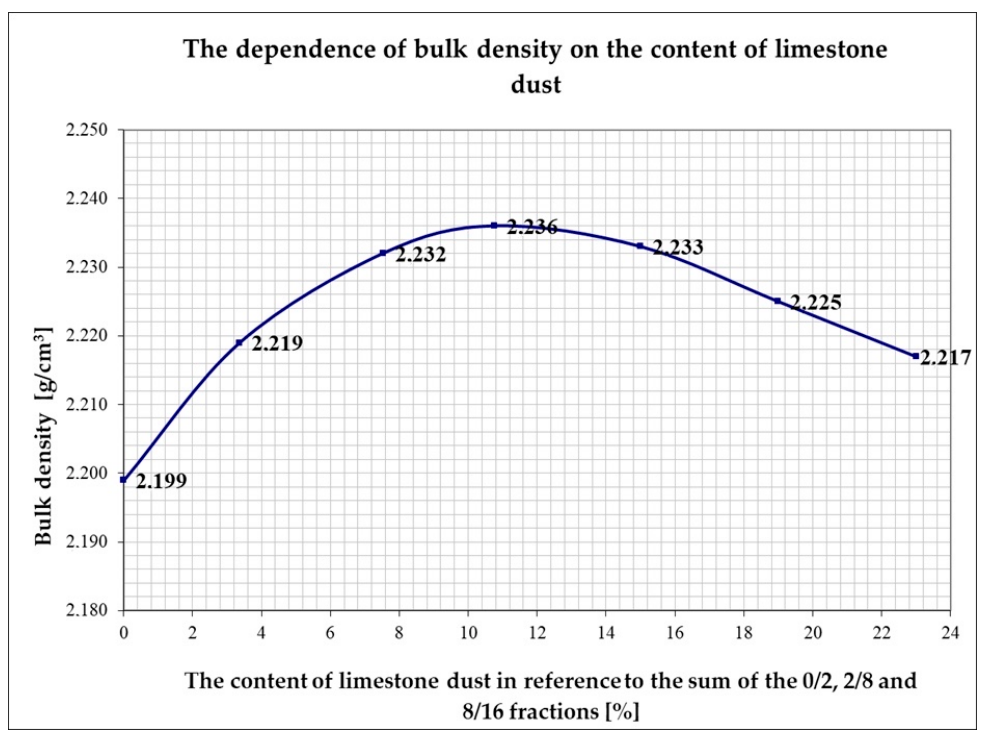
Figure 5. The dependence of the bulk density of the mix of 8/16 mm and 2/8 mm gravel and 0/2 mm sand in reference to the filler in the form of limestone dust.